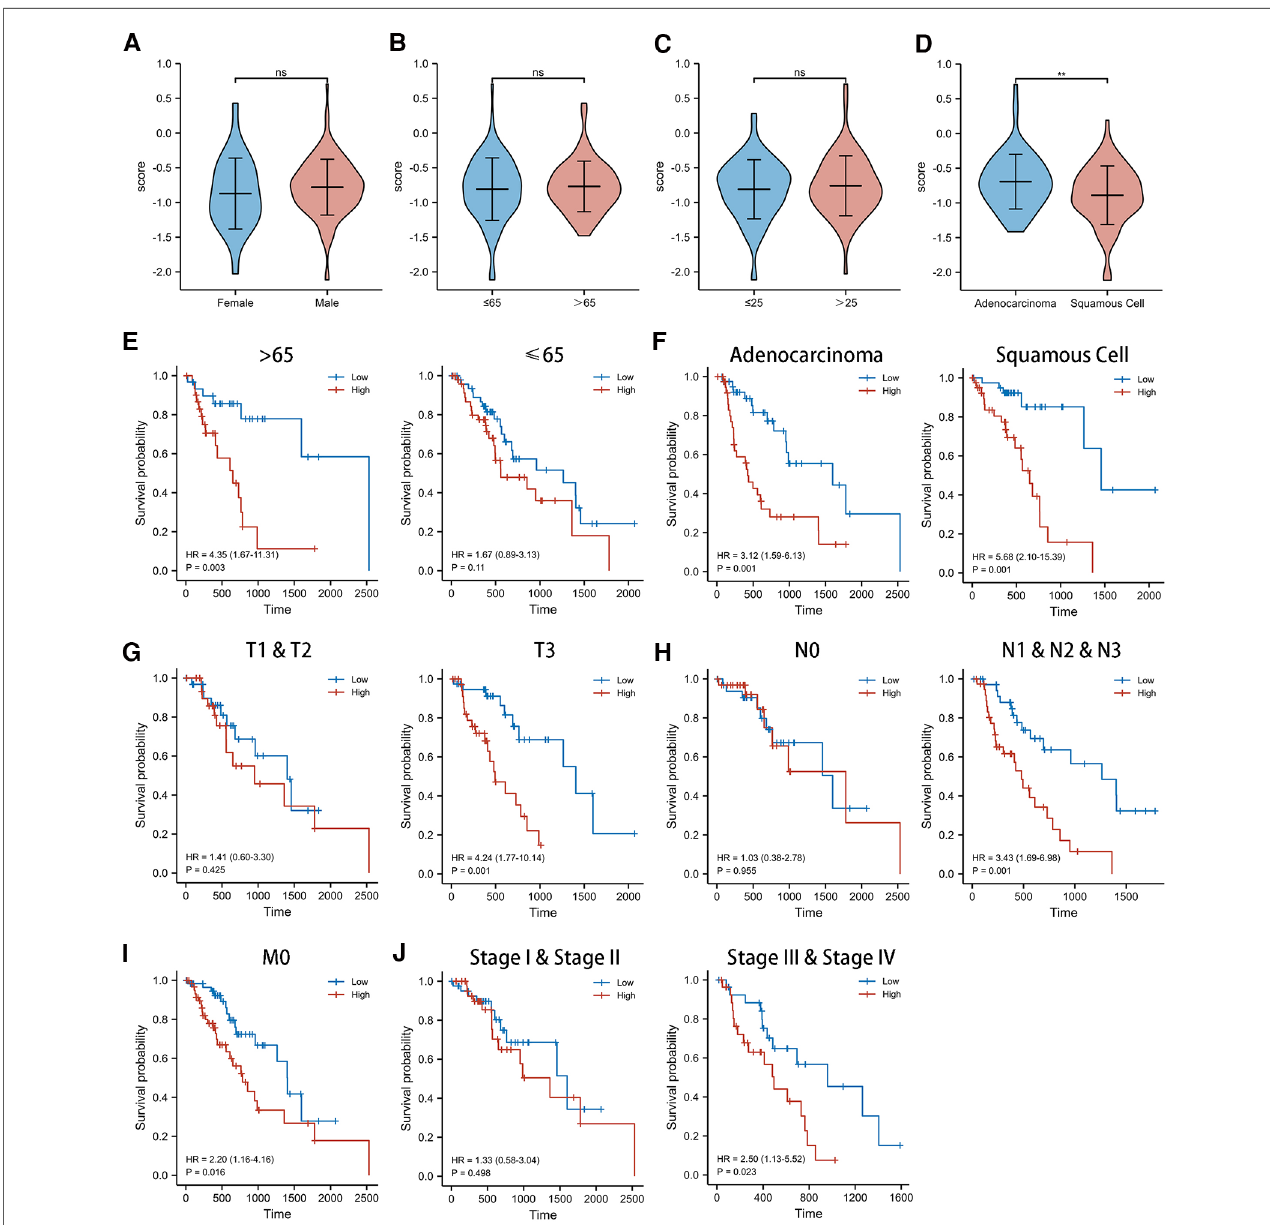
FIGURE 4 Clinicopathological characteristics and survival analysis of different CSRS groups. ( A,B ) CSRS distribution showed no signi fi cant differences in different gender ( A ), age ( B ) and BMI ( C ), while CSRS was higher in patients with EAC than ESCC ( D ). Subgroup survival analysis of age ( E ), pathological staging ( F ), T stage ( G ), N stage ( H ), M stage ( I ) and pathological stage ( J ) between high- and low-CSRS patients. EAC, Esophageal adenocarcinoma; ESCC, Esophageal squamous cell cancer; ns: No signi fi cance; ** p